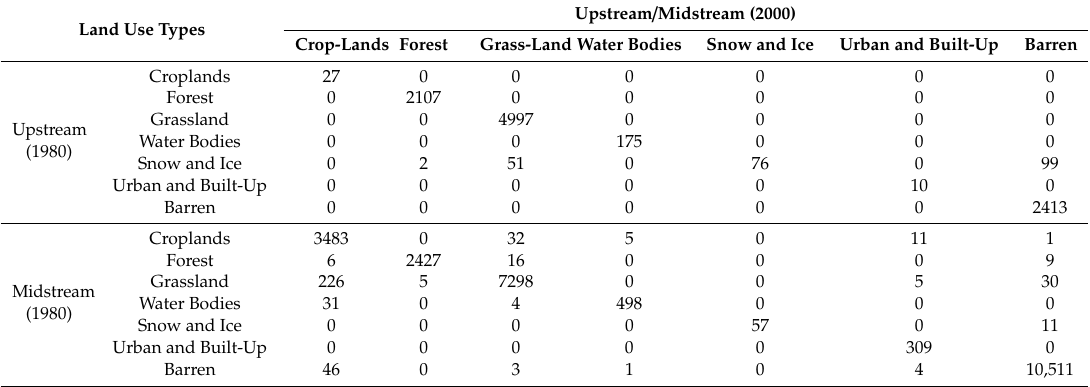
Table 4. The transition matrixes of seven land use types for the upstream and midstream of the Heihe River basins from 1980 to 2000 (unit: km 2